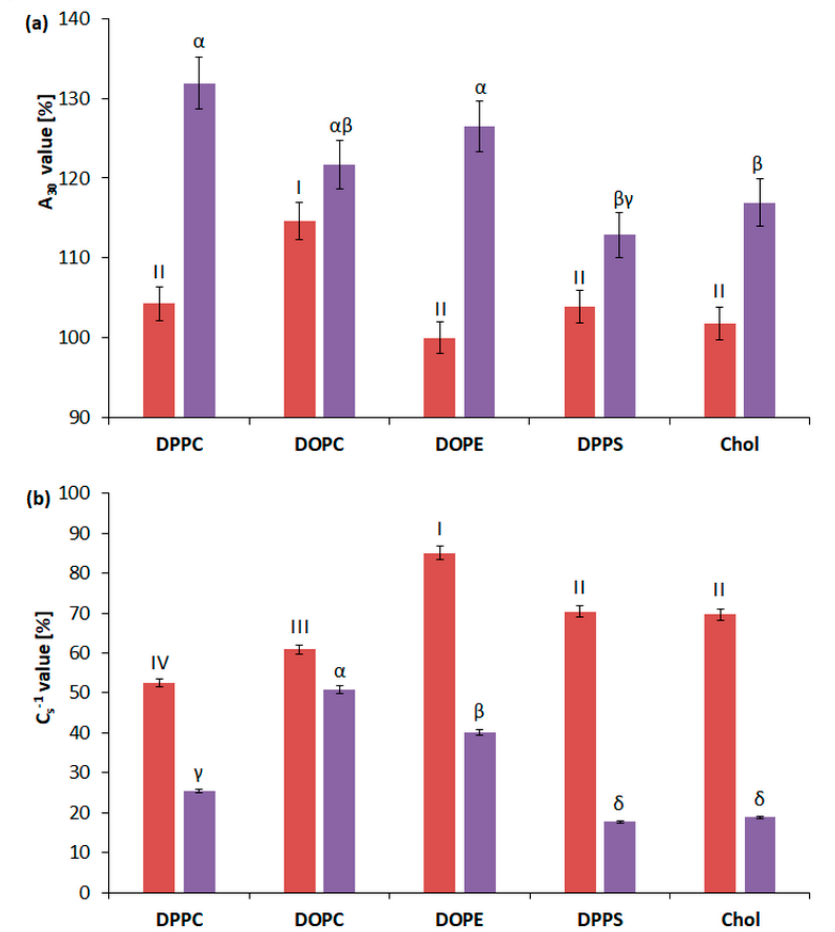
Figure 4. Effect of 3FTxs (at a concentration of 10 ng/mL—red color; at a concentration of 40 ng/mL—purple color) ( a ) onthe limiting area (measured at for π = 30) and ( b ) on static compression modulus vs. surface pressure (C s − 1 ) for representative lipids (phosphatidylcholine (DPPC, (16:0)), phosphatidylcholine (DOPC, (18:1)), phosphatidylserine (DPPS), phosphatidylethanolamine (DOPE), and cholesterol (Chol). Values represent the average ± SD (n = 5). Statistically significant differences between tested lipids were marked: for the 10 ng/mL 3FTx concentration, Roman numerals were used; for the 40 ng/mL 3FTx concentration, the letters of the Greek alphabet were used. For the applied concentrations of 3FTxs, an increase in A 30 with a simultaneous de-